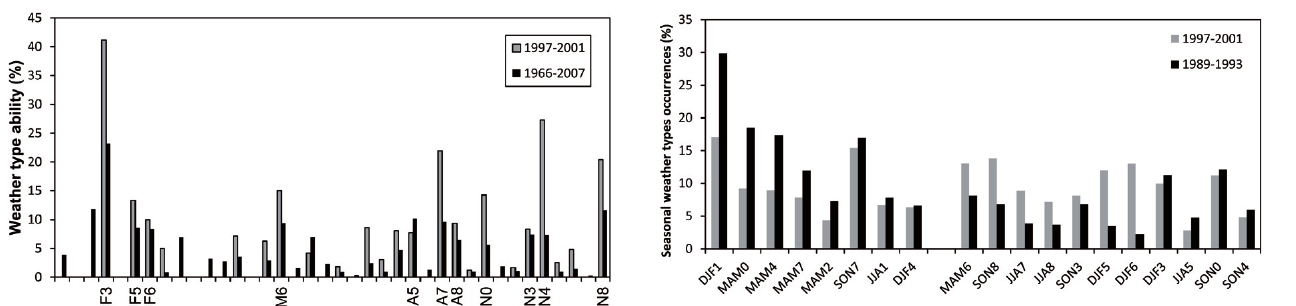
Fig. 8. Comparison of WT occurrences for the periods with (1997– 2001) and without (1989–1993)